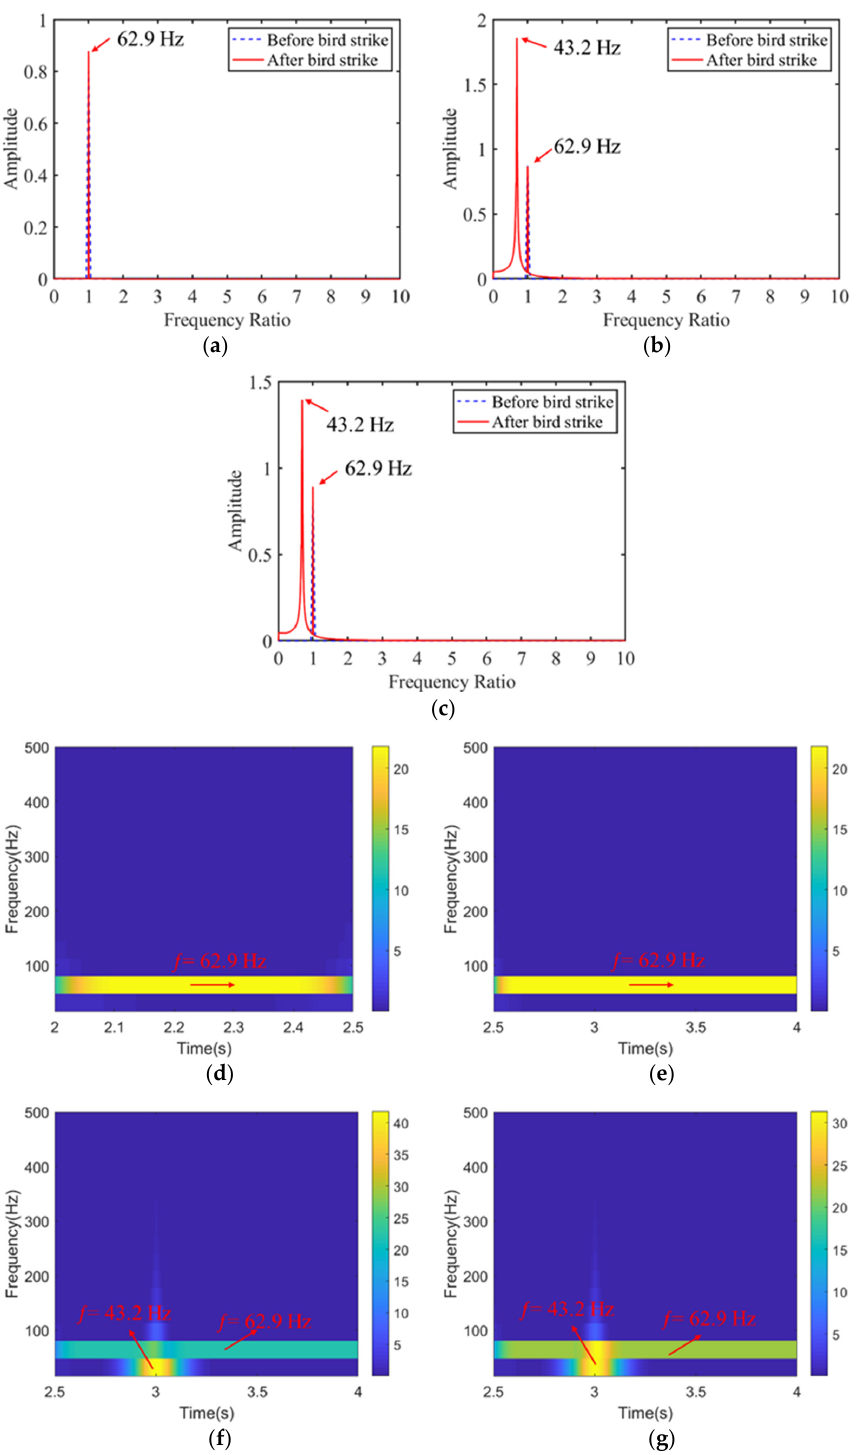
Figure 11. The dynamic response of the fan before and after bird strike: frequency spectrum of ( a ) small flocking bird strike; ( b ) medium flocking bird strike; ( c ) large single bird strike; time-frequency graph of ( d ) no bird strike; ( e ) small flocking bird strike; ( f ) medium flocking bird strike; ( g ) large single bird strike.